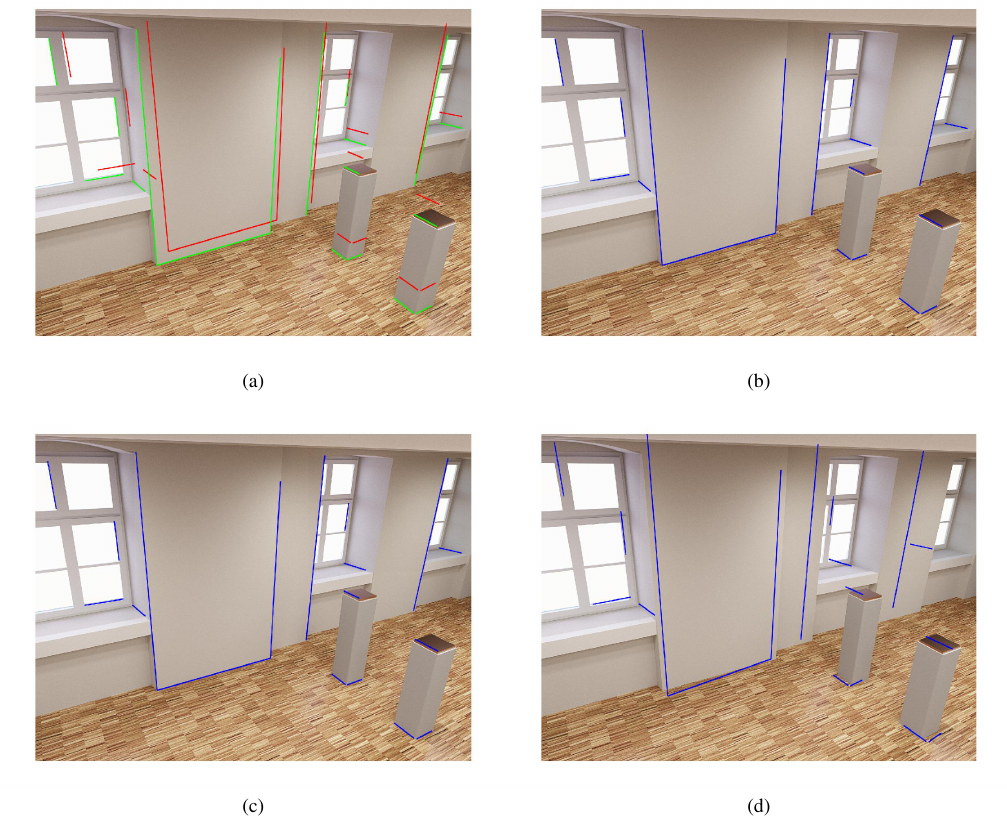
Figure 8. Synthetic image with projected 3D edges using a) ˜P (green) and P (red) b) ˆP , σ l = 1 . 0 and LOA 50 model c) ˆP , σ l = 1 . 0 and LOA 30 model d) ˆP , σ l = 1 . 0 and LOA 10 model